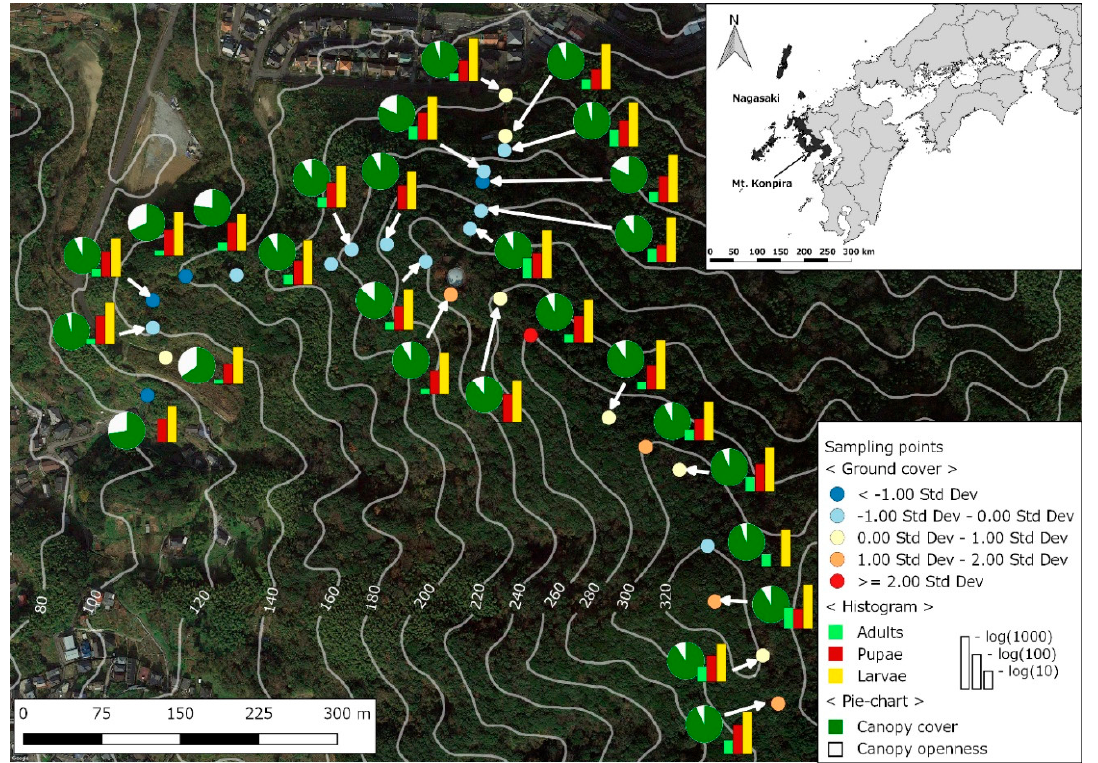
Figure 3. Bamboo mosquito, Tripteroides bambusa , abundance by stage along the altitudinal gradient of Mt Konpira. In the map a histogram shows the cumulative log transformed abundance by stage of Tr. bambusa at each sampling point. The pie chart shows the relationship between canopy cover and canopy openness. White lines show the elevation in m. For further details, please refer to the inset legend. The inset map shows the location of Nagasaki Prefecture in western Kyushu Island, and the location of Mt Konpira. The baseline image is from Google Earth.